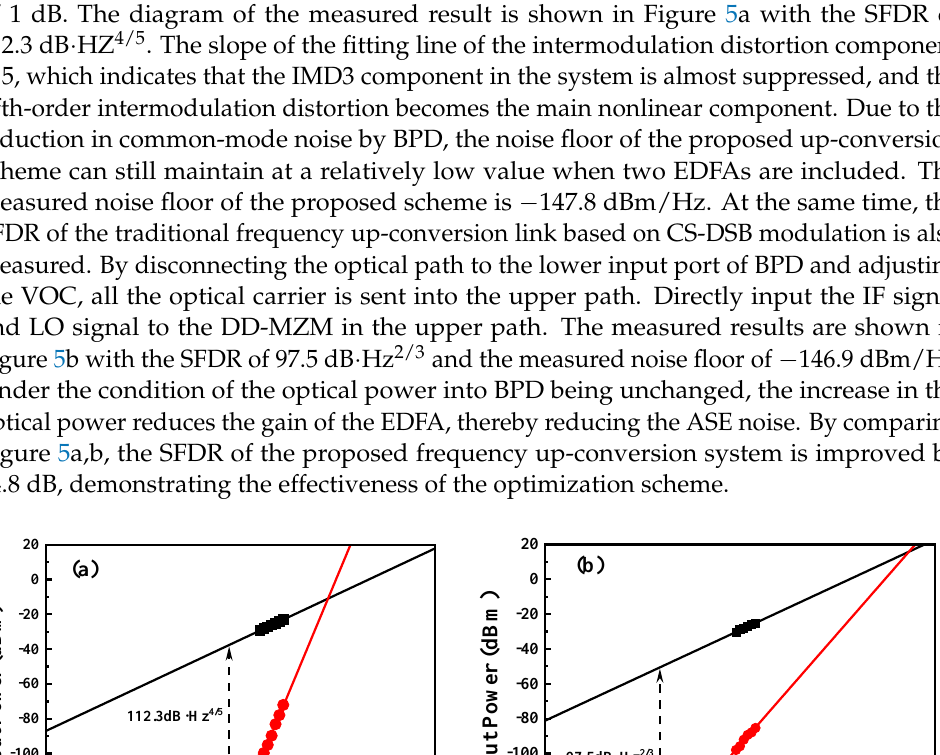
Figure 6a,c,e are the measured electrical spectra of the frequency up-conversion system based on traditional CS-DSB modulation. It can be seen that the intermodulation